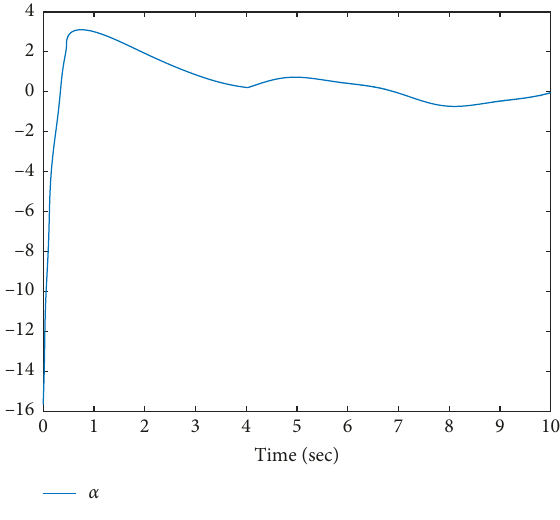
Figure 14: State of virtual control.